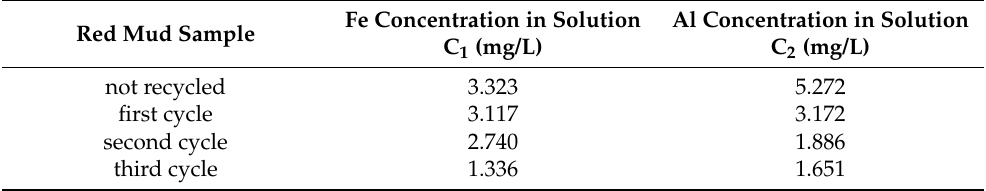
Figure 9. Red mud recycling. (Initial CV concentration = 25 mg/L, discharge voltage = 22 kV, frequency = 50 Hz, aeration O 2 = 3.0 L/min, red mud dosage = 2.0 g, conductivity = 26 μs/cm). Table 1. Fe and Al content in the solution at the end of the